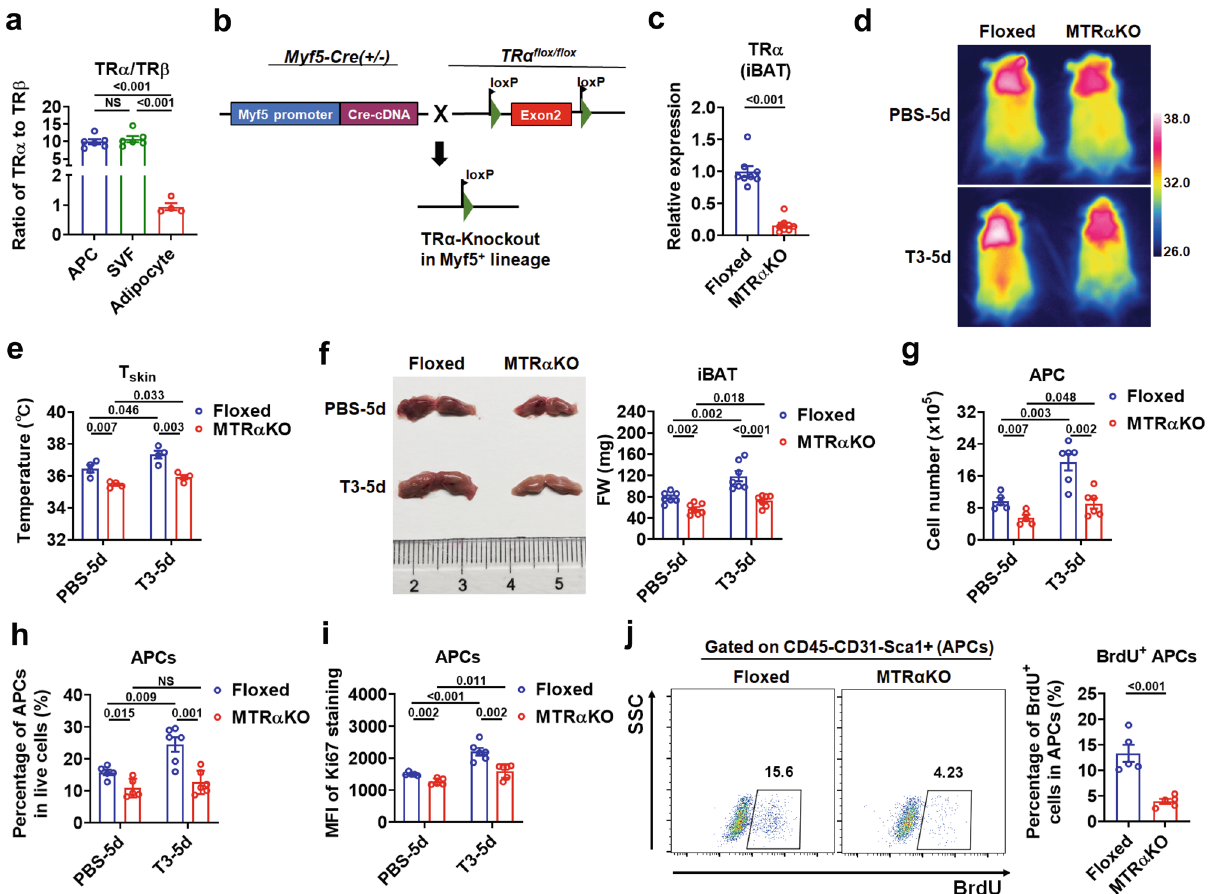
Fig. 3 Deletion of TR α with Myf5-Cre blunts the T3 effect on iBAT hyperplasia. a Ratio of the amount of TR transcripts (TR α vs TR β ) assessed by qRT ‐ PCR in APCs ( n = 6), cultured SVF cells ( n = 6) and SVF-derived mature brown adipocytes ( n = 4). b Breeding scheme for generating the MTR α KO mice. c Relative TR α mRNA levels in iBAT depots of TR α Floxed (Floxed) and MTR α KO mice ( n = 8). d , e Representative infrared images ( d ) and quanti fi cation ( e ) of average dorsal T skin of Floxed and MTR α KO mice with daily PBS or 0.5X standard dose of T3 injection for 5 d ( n = 4). f Representative photograph (left) and FW of iBAT (right) of Floxed and MTR α KO mice with daily PBS or 0.5X standard dose of T3 injection dose for 5 d ( n = 7). g Number of APCs in iBAT per mouse from Floxed and MTR α KO mice with daily PBS ( n = 5) or 0.5X standard dose of T3 ( n = 6) injection for 5 d. h Percentage of APCs in live SVF cells of iBAT from Floxed and MTR α KO mice with daily PBS ( n = 5) or 0.5X standard dose of T3 ( n = 6) injection for 5 d. i MFI of Ki67 staining in APCs of iBAT from Floxed and MTR α KO mice with daily PBS ( n = 5) or 0.5X standard dose of T3 ( n = 6) injection for 5 d. j FACS plot and quanti fi cation of the BrdU + APCs in iBAT from Floxed and MTR α KO mice with daily T3 injection at 0.5X standard dose for 5 d ( n = 5). Cells were pre-gated on live CD45 − CD31 − Sca1 + cells. Means ± SEM are shown. P values were calculated by two-tailed unpaired Student ’ s t test for a, c , e – j . NS, not signi fi cant. Two- way ANOVA was performed for the data in g – i additionally, and the results were show in Supplementary Table 1 – 3. Source data are provided as a Source Data fi